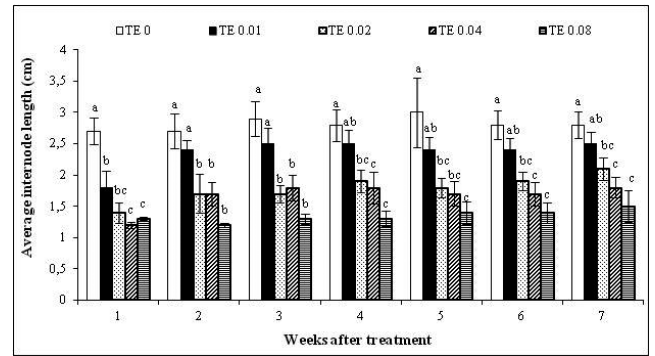
Fig. 3 - Average internode length in Patriot bermudagrass treated with different rates of TE (kg a.i. ha -1 ). Within the same week, different letters show significantly different values for P≤0.05 (LSD test). Vertical bars show se of the means (n=5); ns= not